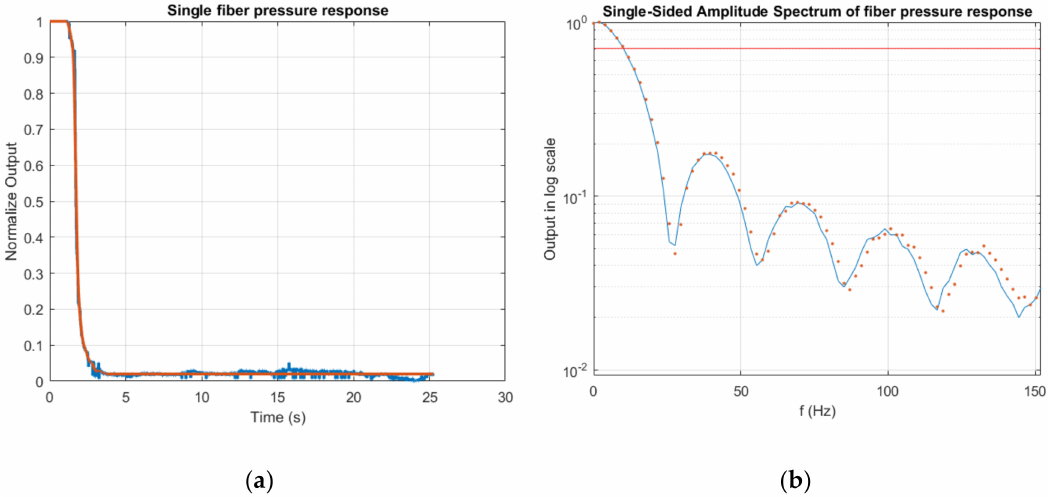
Figure 9. ( a ) Time response of a fiber, after a pressure is applied: in blue is reported the response measured and in red the theoretical response calculated considering the frequency response of the electronics. ( b ) Frequency response retrieved from the time response data calculating the derivative of the Fourier transform. In red is represented the − 3 dB line, the theoretical impulse response of the system is plotted with red